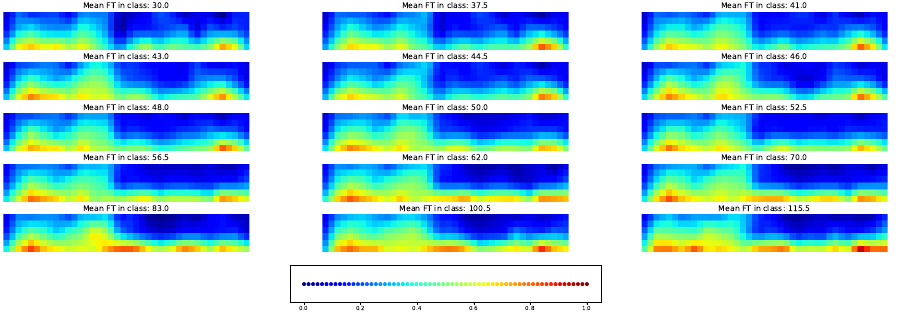
Figure 17. Average Score-CAM maps for time classes and the union SNP set. Figure S8 gives the same data with higher